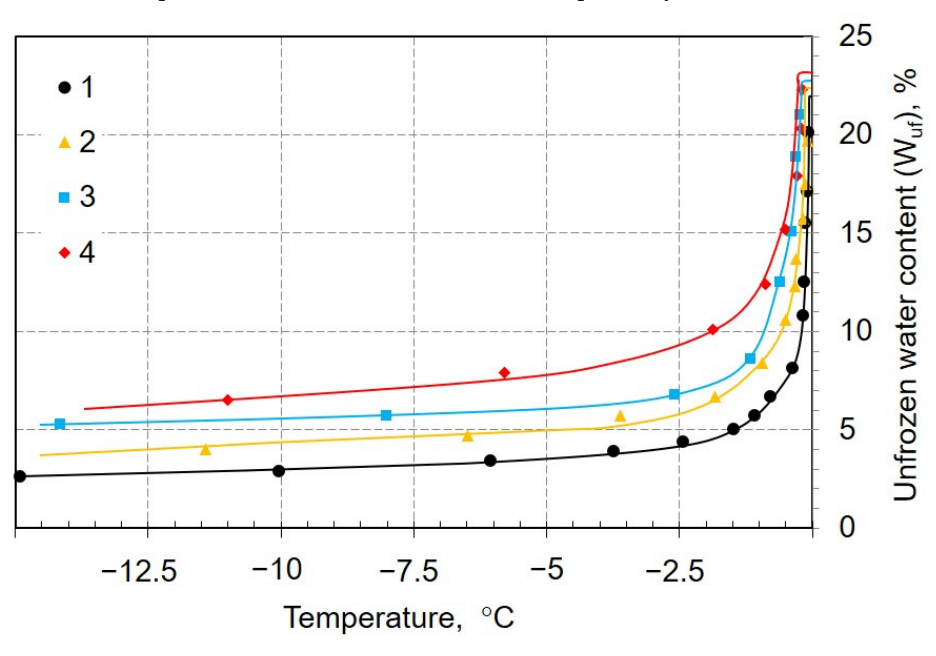
Organic Matter Content **, %